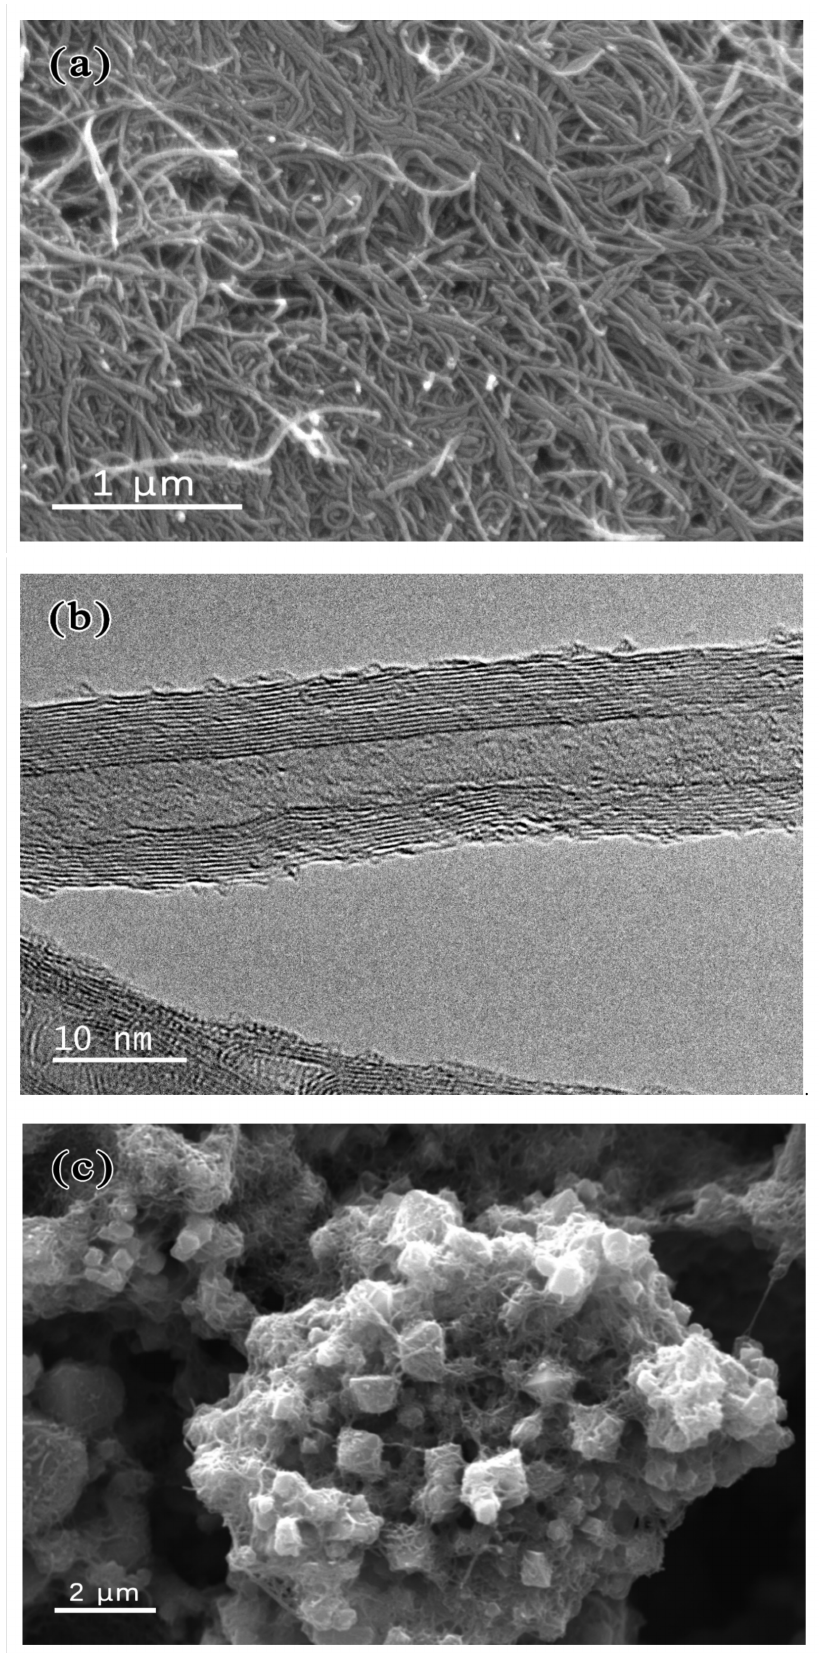
Figure 5. Morphology of NCNT-800 sample captured by SEM ( a ), TEM ( b ), and SEM image of B-NCNT-800 electrode ( c